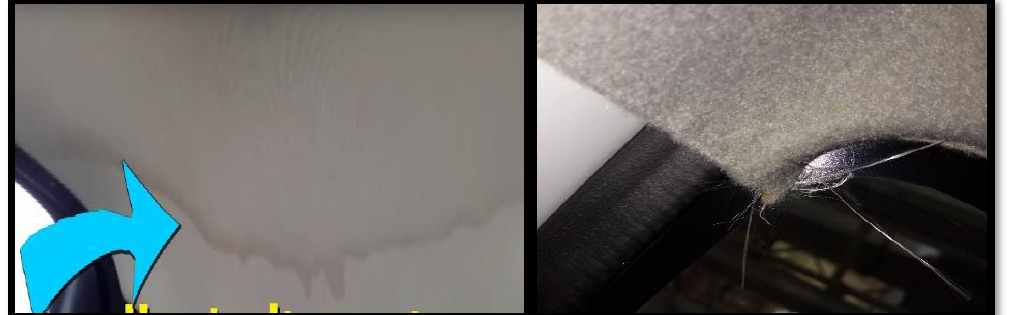
Figure 2. Defects selected for Kaizen-2 (stain marks on roof and poor cutting of mats)